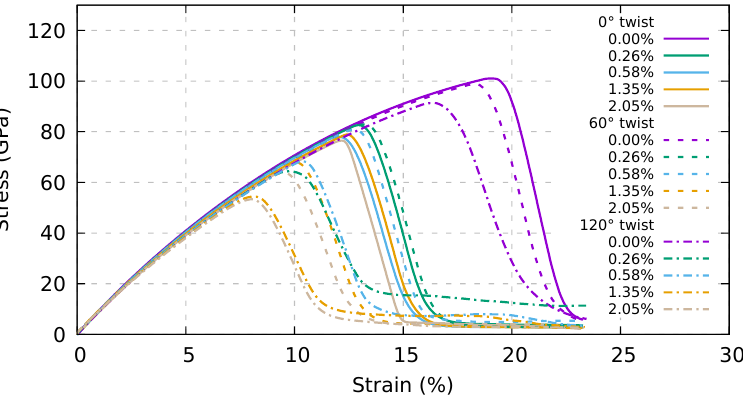
Figure 4. Dependence of the stress–strain response on twisting and on the percentage of linkers for an infinite bundle composed of ( 6,6 ) CNTs with a periodic supercell length of 20 nm. AIREBO-mod potential and a constant strain velocity equal to 1.0 Å/ps were used.